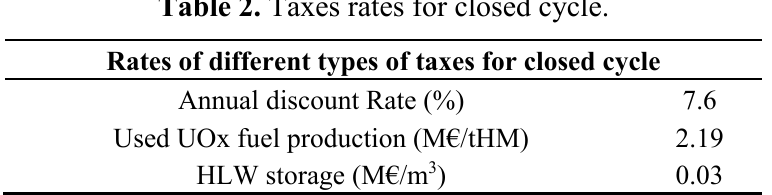
Table 2. Taxes rates for closed